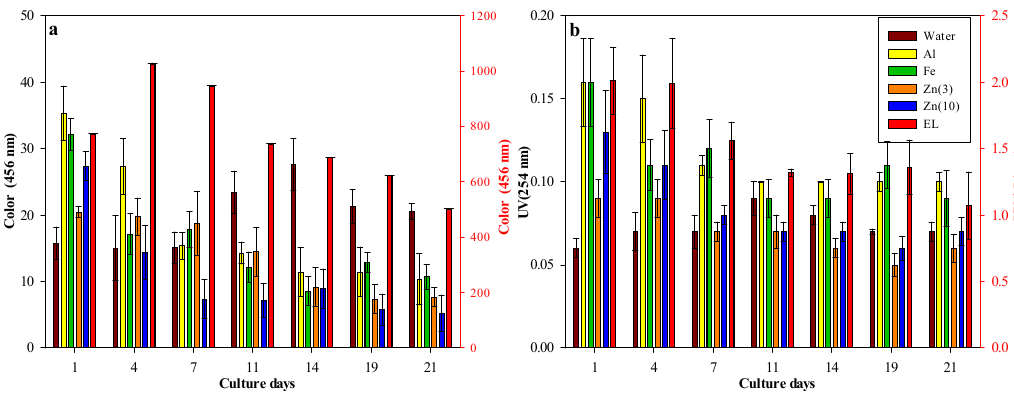
Figure 3. Variations in color and UV values (±S.D.) in the different treatments ( a is color, b is UV).